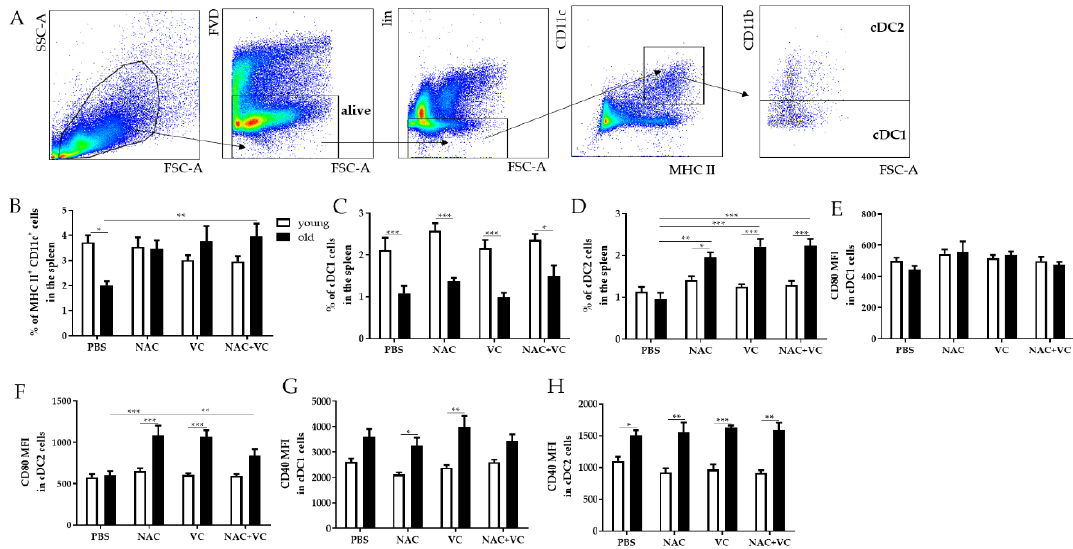
Figure 5. Dendritic cell subsets in the spleen. ( A ) Gating strategy for DC subsets. After excluding dead cells using the FVD Zombie Violet, lineage negative (lin-) CD3 - NKp46 - CD19 - cells were considered. FACS plots showing the gating for CD11c + MHC II + DCs, CD11c + MHC II + CD11b - classical DCs (cDC1) and CD11c + MHC II + CD11b + DCs (cDC2) are reported. Frequency of ( B ) CD11c + MHC II + DCs, ( C ) cDC1, ( D ) cDC2, and MFI of ( E ) CD80 in cDC1, ( F ) CD80 in cDC2, ( G ) CD40 in cDC1, and ( H ) CD40 in cDC2 in the spleen of young (white columns) and old (black columns) mice treated with PBS, NAC, Vc, or NAC+Vc. Data are shown as mean ± SEM. Two-way ANOVA, Tukey post-hoc test. * p < 0.05; ** p < 0.01; *** p < 0.0001.